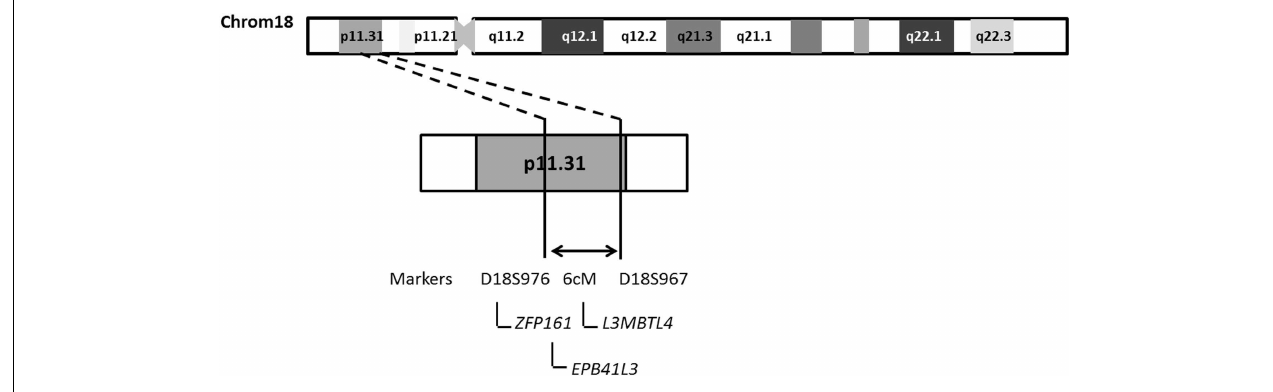
FIGURE 4 | Schematic representation of chromosome 18 indicating the region likely to contain the candidate locus identified in F-10.